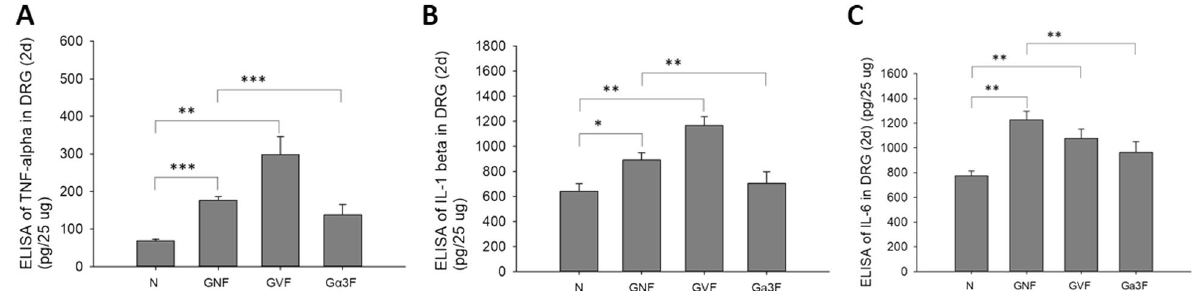
Fig. 6 Effects of AAV‑GlyRα3 on the expression level of cytokines in the L5 DRGs of CFA‑treated rats. For this experiment, CFA (100 μg/100 μl) hind paw injection was administered 8 weeks after the intrathecal injection of AAV‑GlyRα3 (2.5 10 12 vg). After 2 days of CFA treatment, L5 DRGs × (25 μg/100 μl) were collected to evaluate cytokines expression. By ELISAs, the expression of A TNF‑α, B IL‑1β and C IL‑6 was determined. The results are expressed as the means SE, and the data shown represent from three to five independent experiments. Mann–Whitney U test was used. ± * p < 0.05, ** p < 0.01, *** p <